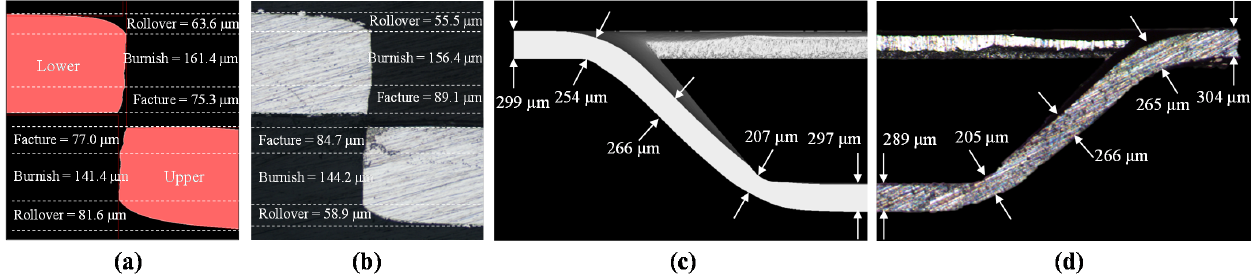
Figure 8. Comparison of deformed shapes in cross section view via ( a ) FE analysis with critical damage value of 3.6 and ( b ) experiment at forming height of 408 μ m; ( c ) FE analysis with a critical damage value of 3.6 and ( d ) experiment at forming height of 1.63 mm.